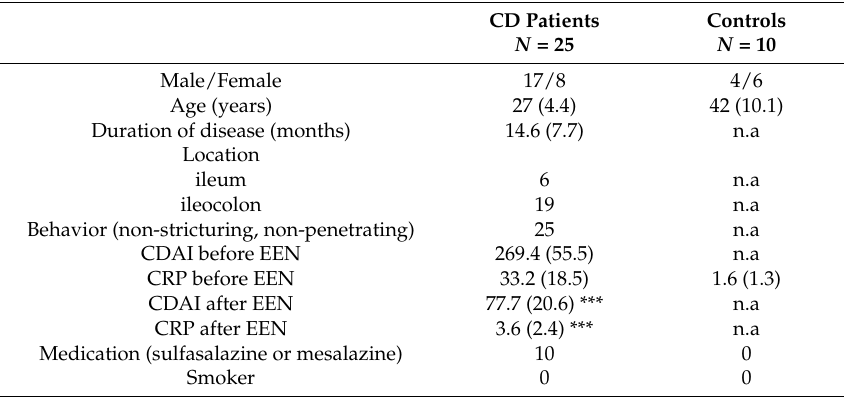
Table 2. Characteristics of all